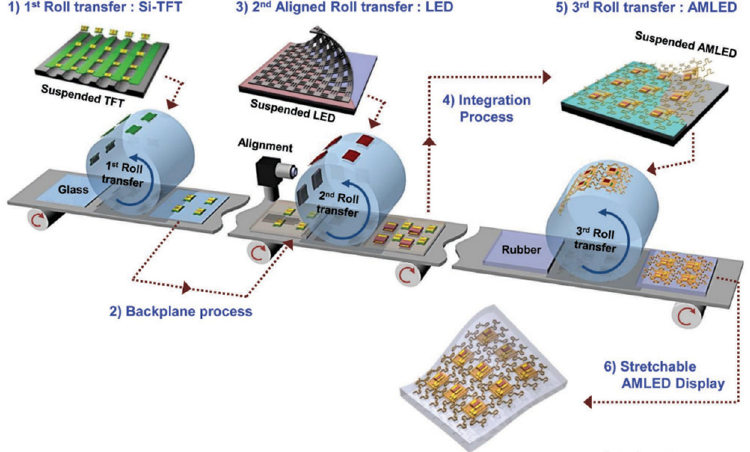
Figure 6. Schematic diagram of the steps for assembling a flexible AMLED display using three-roll transfer technology. Reproduced from [51], with permission from John Wiley and Sons, 2017.